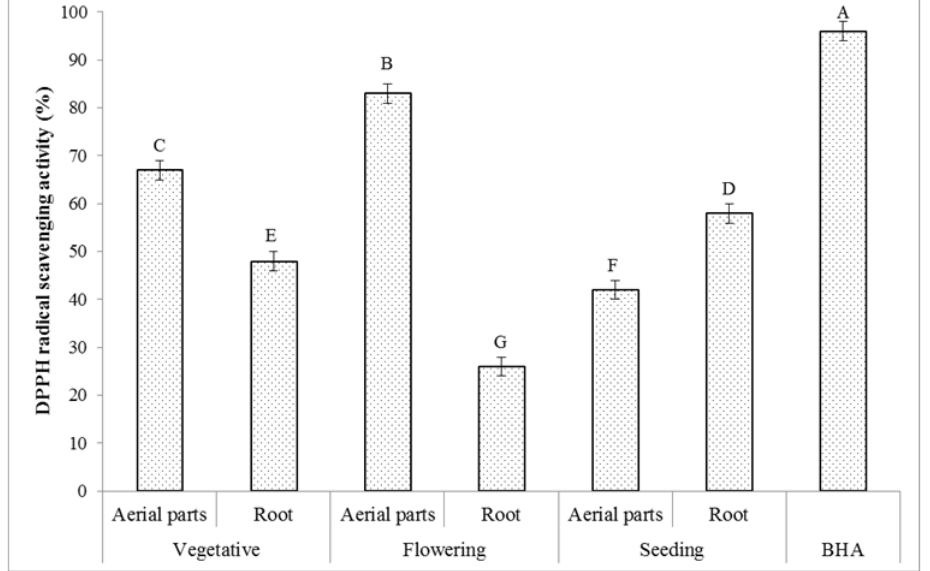
Figure 2. DPPH radical scavenging activity ( n = 3) of the extracts of the T. polium aerial parts and root at different phenological stages. The extract concentration is 200 µg/mL. Various letters indicate statistically significant differences ( p < 0.05).